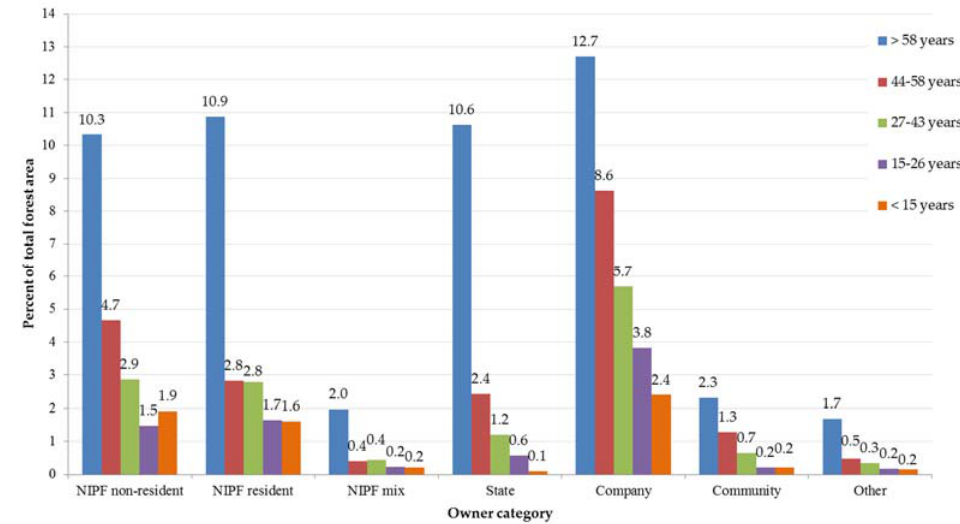
Figure 5. Distribution of the total forest area (2674 km 2 ) among owner categories in our focus study area within Vilhelmina municipality, Sweden. The distribution is presented in intervals of forest age: from >58 years old (not subjected to final felling) to <15 years. Note that data on owner category refers to the situation in January 2016. Land ownership is categorized into State, Company (large ‐ scale forest companies), NIPF resident and NIPF non ‐ resident (non ‐ industrial private forest owners identified as living in or outside the municipality), NIPF mix (a mix of NIPF resident and NIPF non ‐ resident owners), Community (a large forest common, the municipality, and some smaller village commons) and Other (the church, foundations, and unidentified owners).